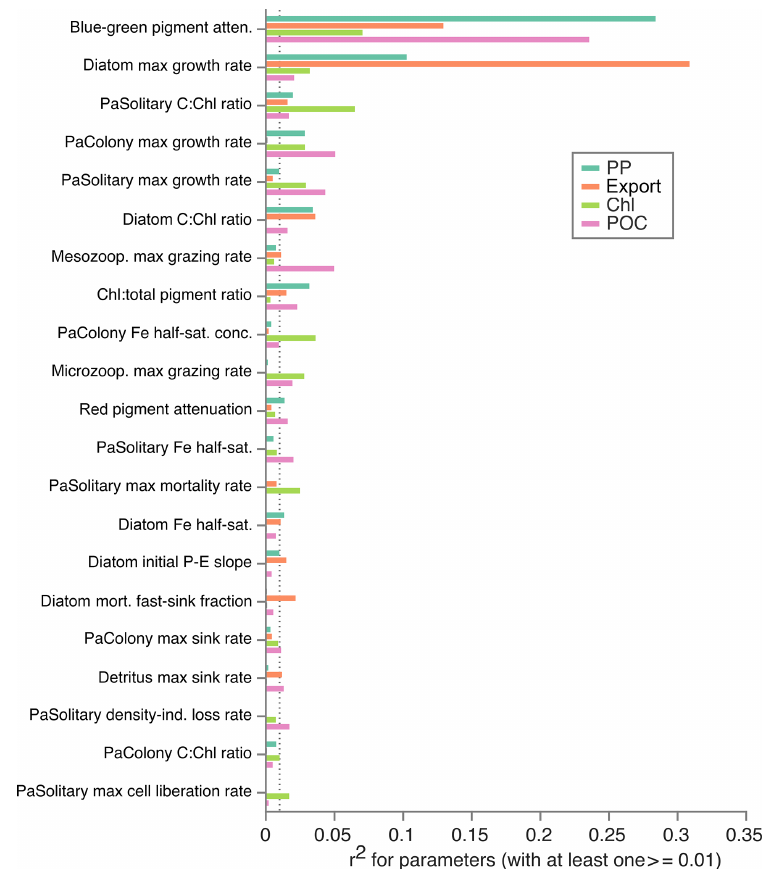
Figure 2. Variance explained in model outputs by parameters during sensitivity tests using Latin hypercube sampling of parameter space. Only parameters with at least one r 2 value greater than or equal to 0.01 (vertical dotted line) are